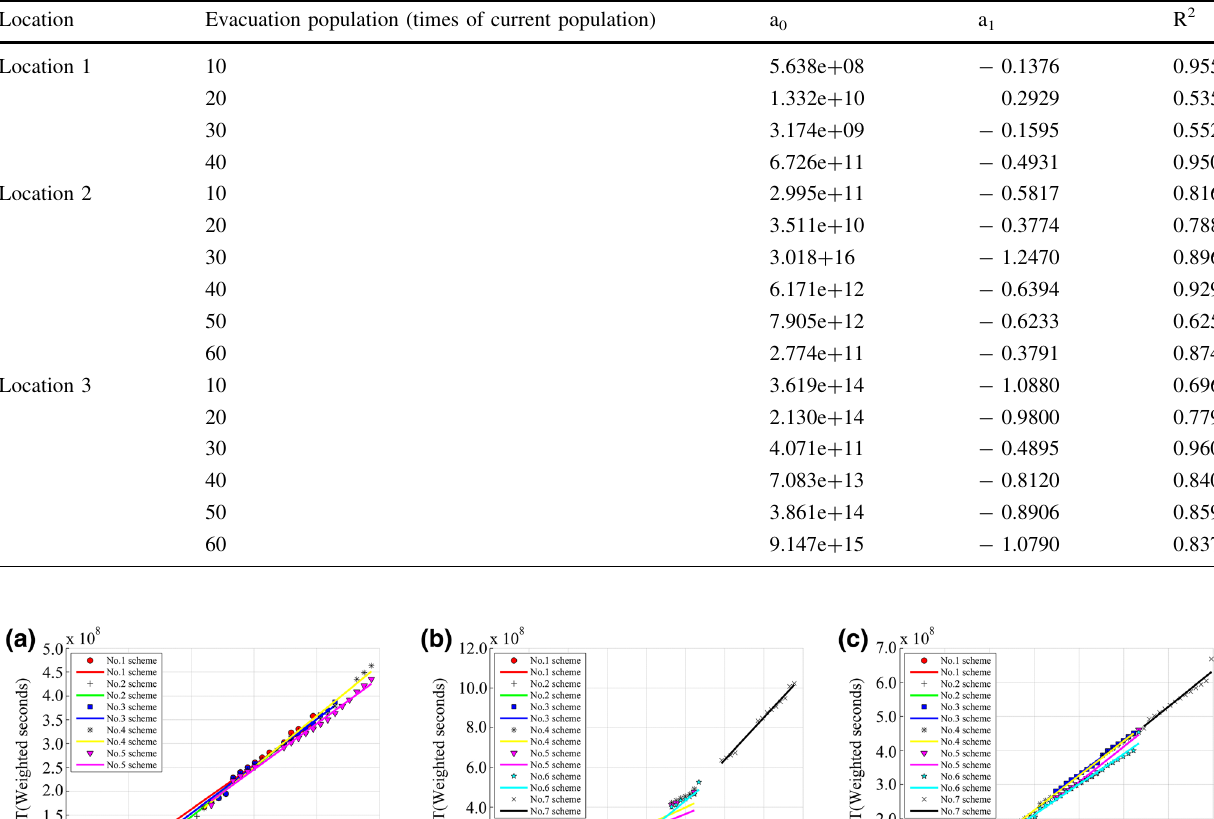
Table 2 Estimated parameter values of TWET and TSA relationship for different evacuation population size and community location scenarios Location